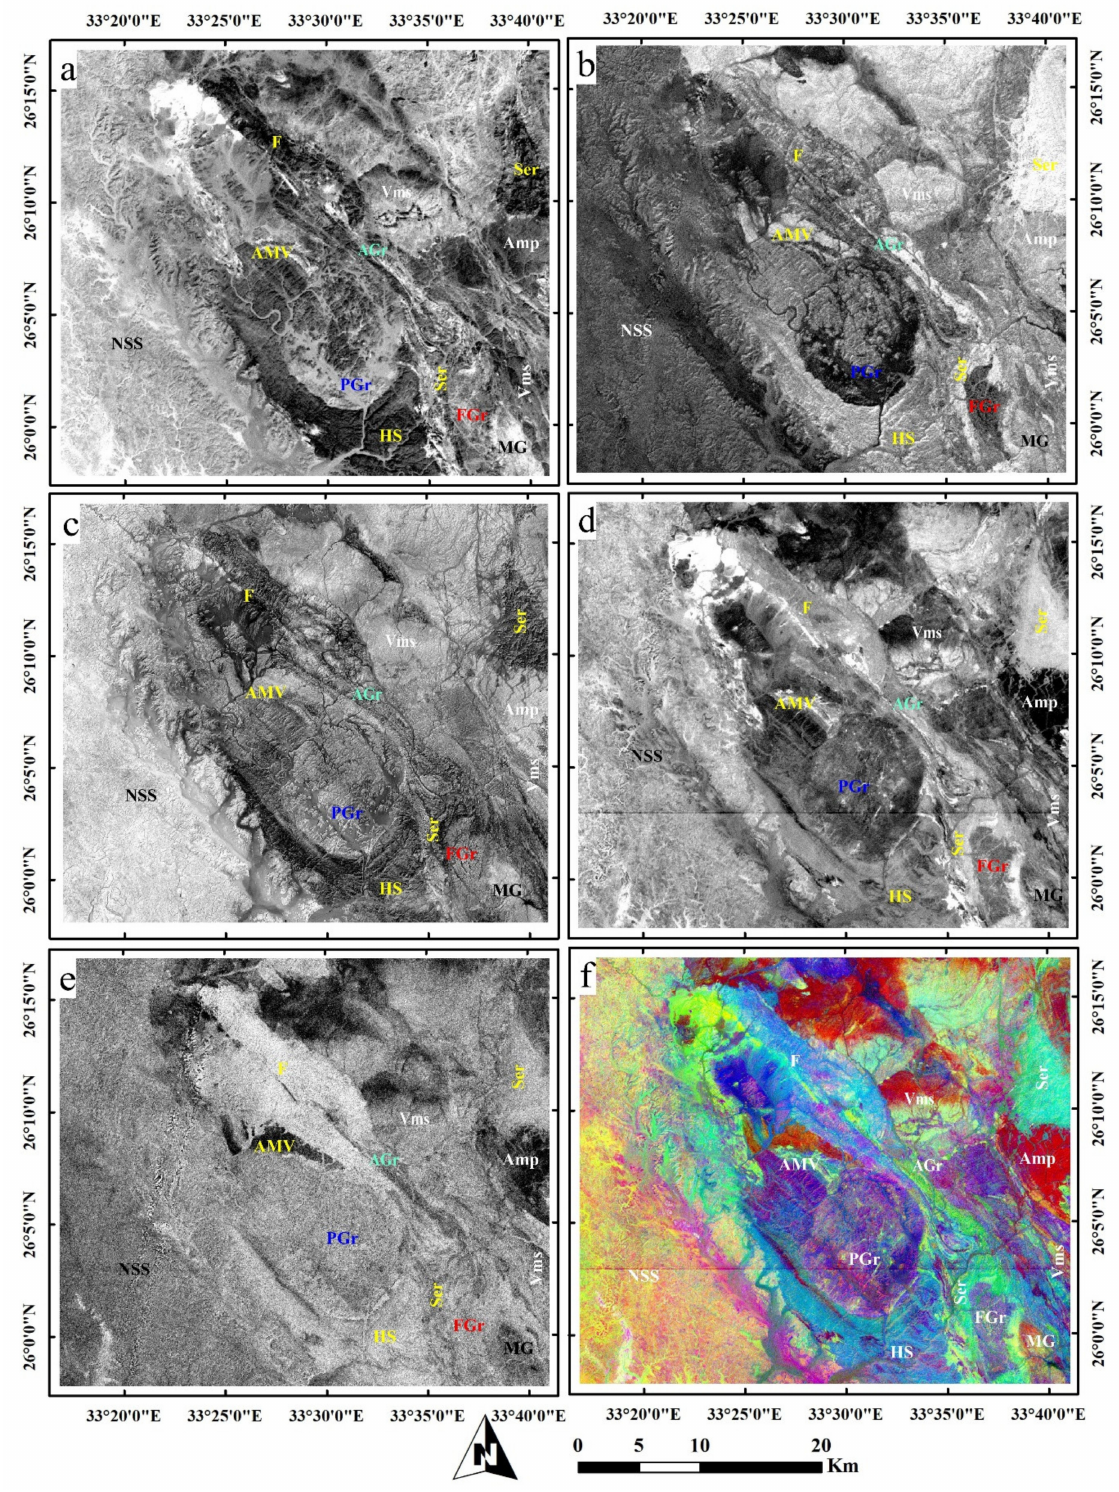
Figure 7. Allocation of ( a ) hydroxyl-bearing minerals (BR 4/9), ( b ) chlorite-calcite-epidote (RBD (7 + 9)/8), ( c ) ox- ide/hydroxide minerals (DPC2), ( d ) argillic alteration (DPC2), ( e ) propylitic alteration (DPC3) as a bright pixels of ASTER data. ( f )FCC of ( c – e ) images, respectively, in